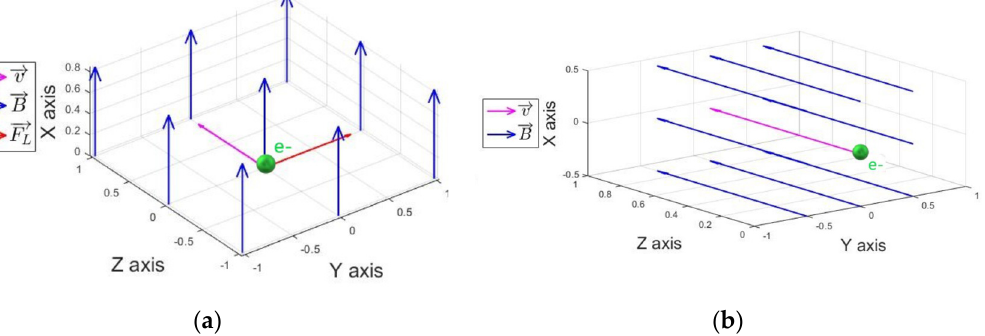
Figure 9. Illustration of charged particle tracking with Lorentz force due to magnetic field perpen ‐ dicular ( a ) and parallel ( b ) to the radiation beam. ular ( a ) and parallel ( b ) to the radiation